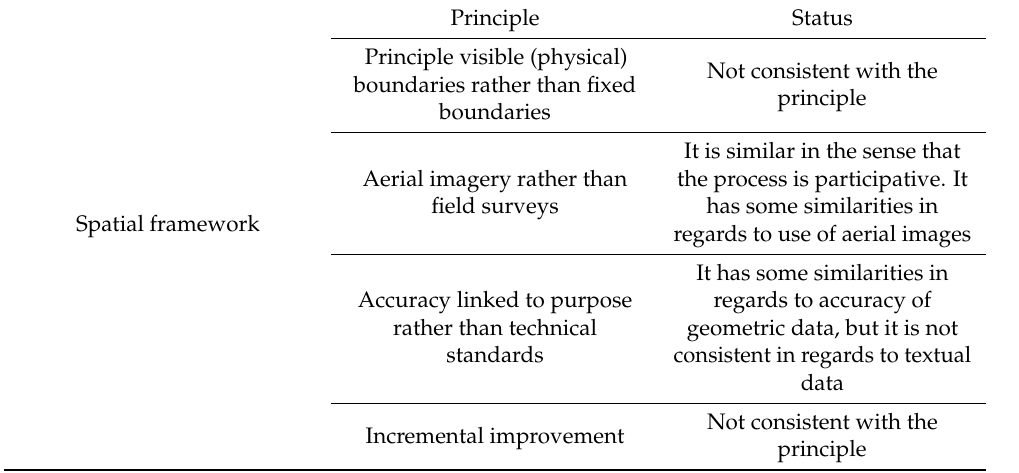
Table 9. Consistency of Romanian practice with the fit for purpose principles for the spatial